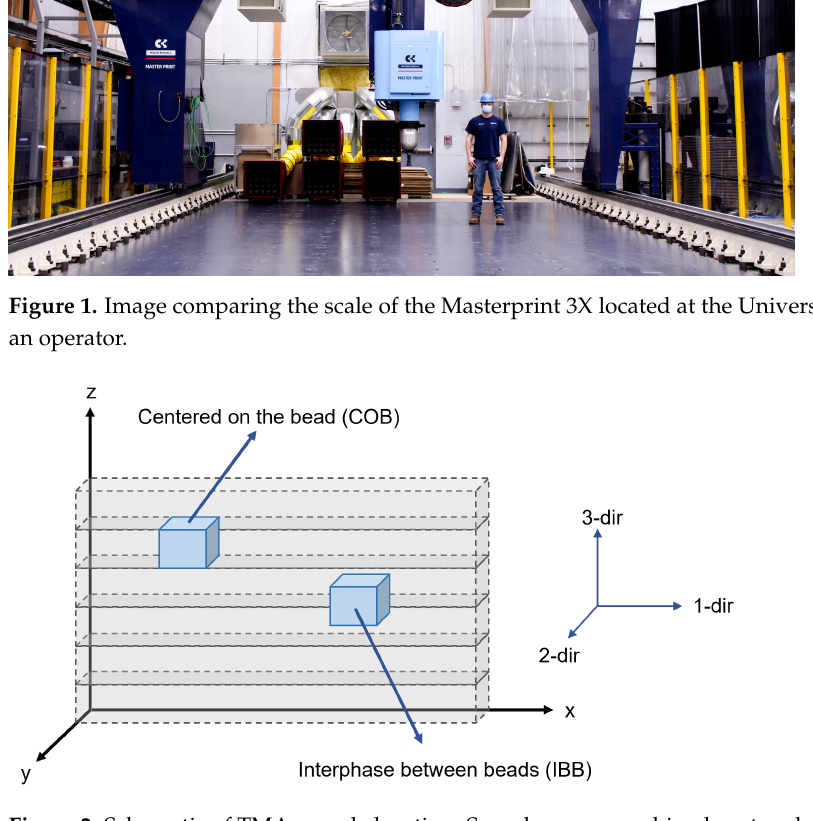
Figure 2. Schematic of TMA sample location. Samples were machined centered on the bead (COB) and at the interphase between beads (IBB). The TMA test was performed along the bead direction (1-dir), across the bead direction (2-dir), and through the bead thickness